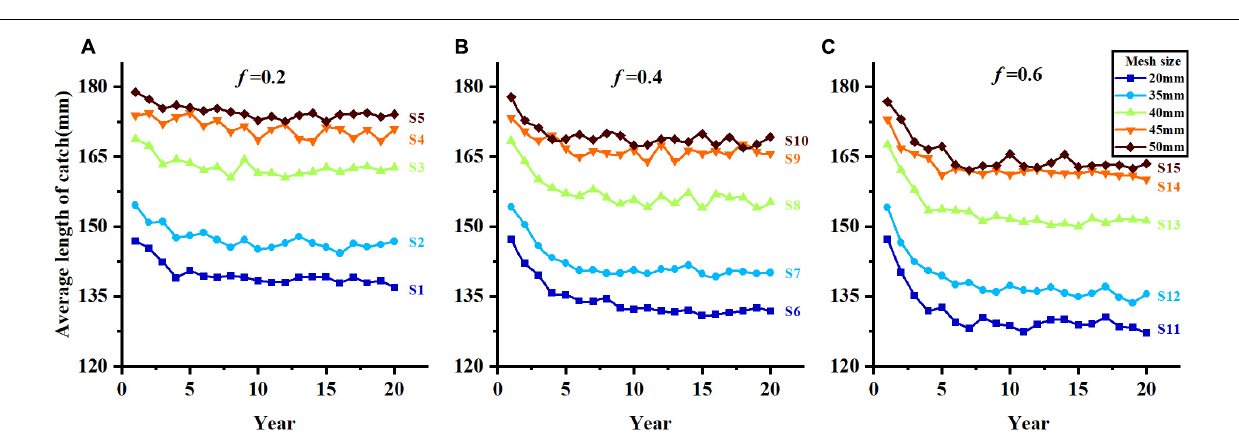
individuals. We first run for 100 years without harvesting to ensure that the population keeps equilibrium. All results are displayed from this time onward. After then, selective harvest